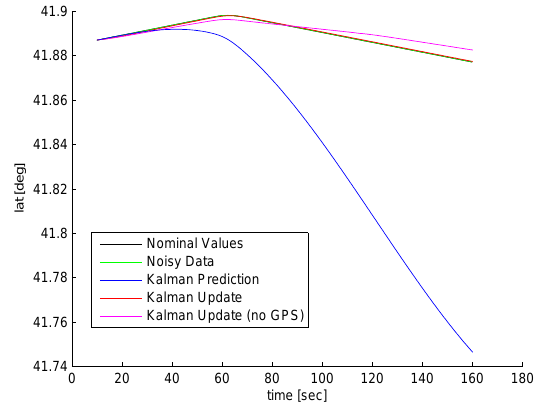
Figure 9: Latitude estimation (Roma Sequence). Nominal value (black line), Kalman Prediction without GPS (blue line), Kalman Update (red line), Kalman Update without GPS (magenta